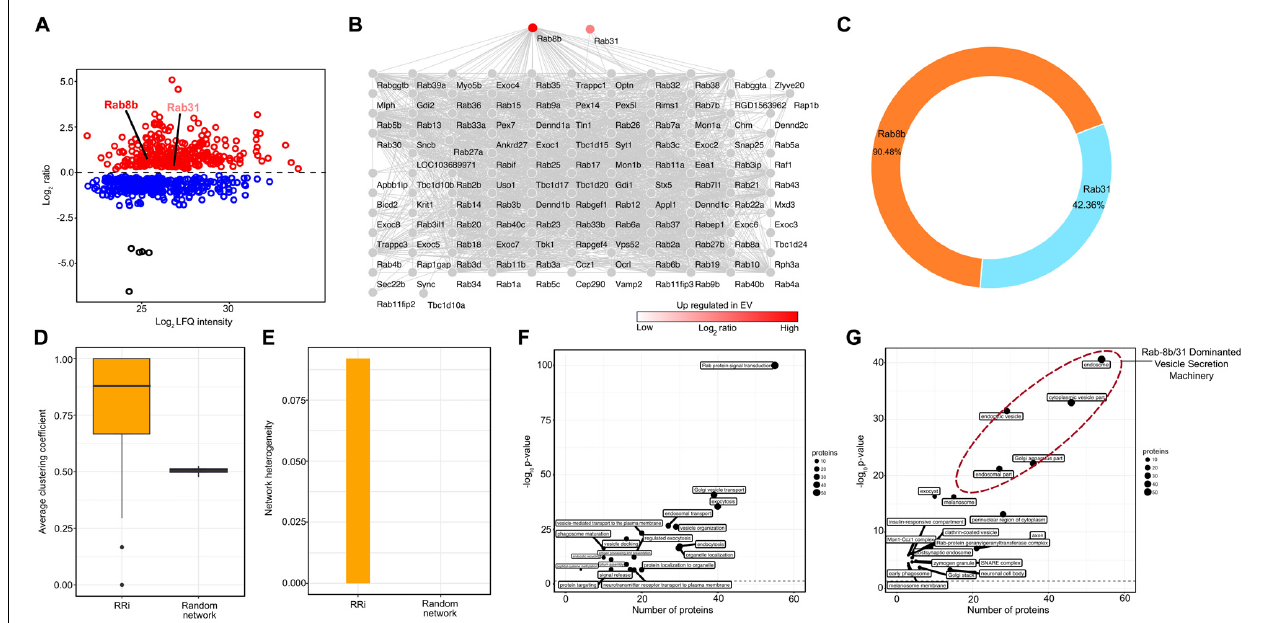
FIGURE 2 | Protein–protein network and pathway analysis of Rab8b and Rab31 proteins. (A) Scatter plot showing enriched proteins in EV in response to treatment with FGF2. Two Rab proteins Rab8b and Rab31 are upregulated (red color) in bFGF-induced EV proteome. (B) Network representation RRi derived from STRING DB. (C) Donut plot showing the percentages of direct and indirect interactions of Rab8b and Rab3 . (D) Average clustering coefficient distributions for the RRi and random networks. (E) Network heterogeneity of RRi and random networks. (F,G) Scatter plot of enriched biological processes and KEGG pathways and cellular components of RRi. The –log 10 P value indicates enrichment of pathway. Note: red color indicates